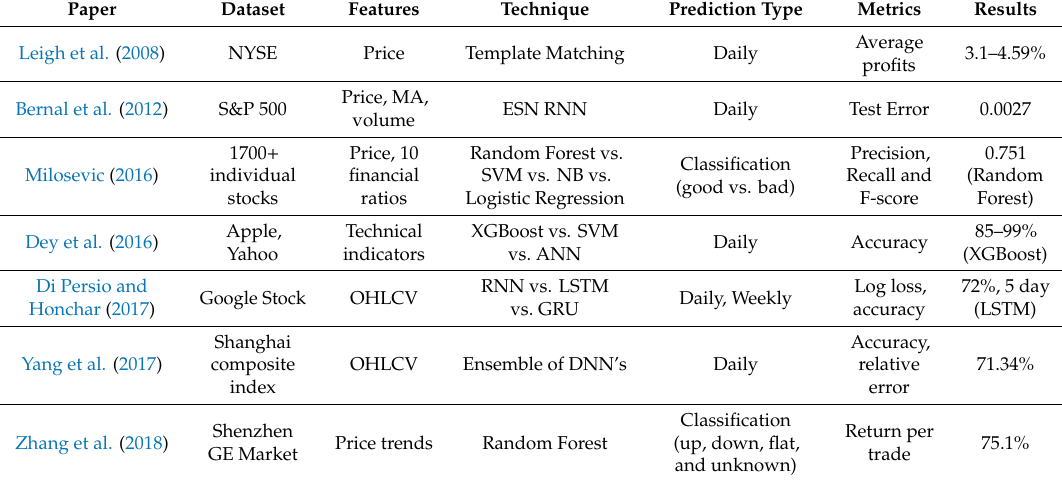
Table 1. Summary of literature on ML approaches applied to stock